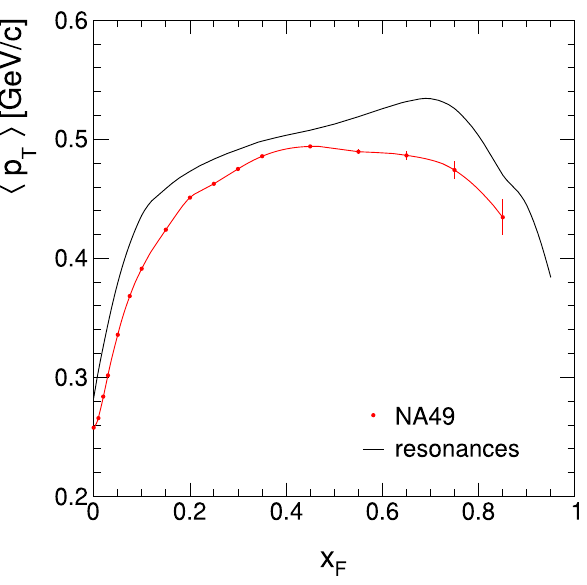
Fig. 194 Mean p T for π − from the complete resonance sample of Table 9 as a function of x F in comparison to the measured inclusive data from NA49